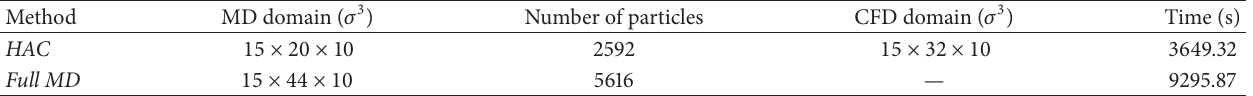
Table 2: Detailed time consuming for the HAC method and the full MD simulation.